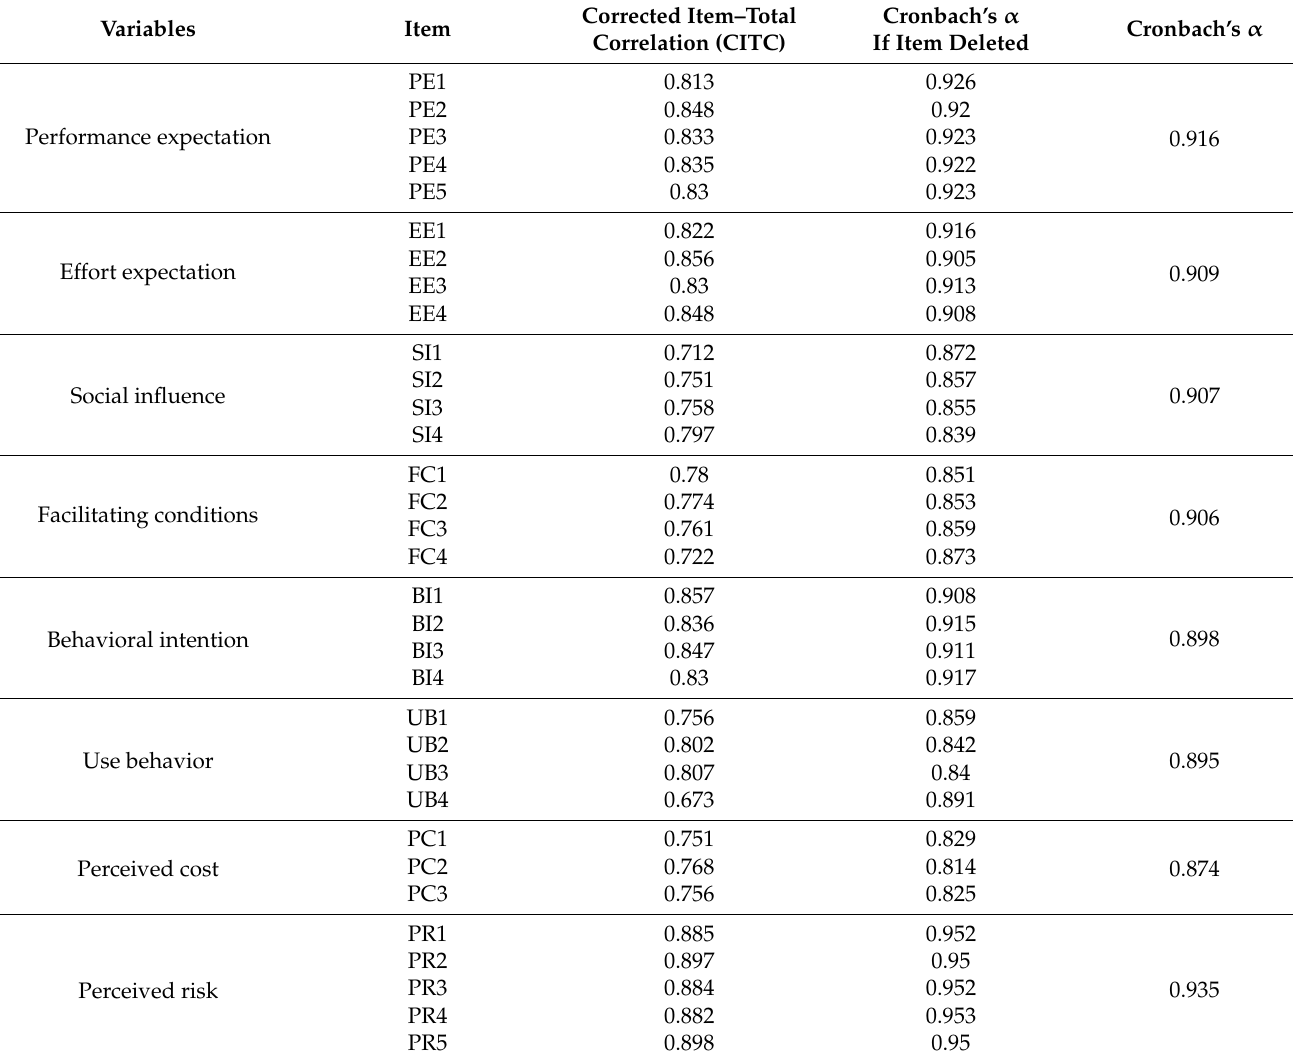
Table 2. Questionnaire reliability